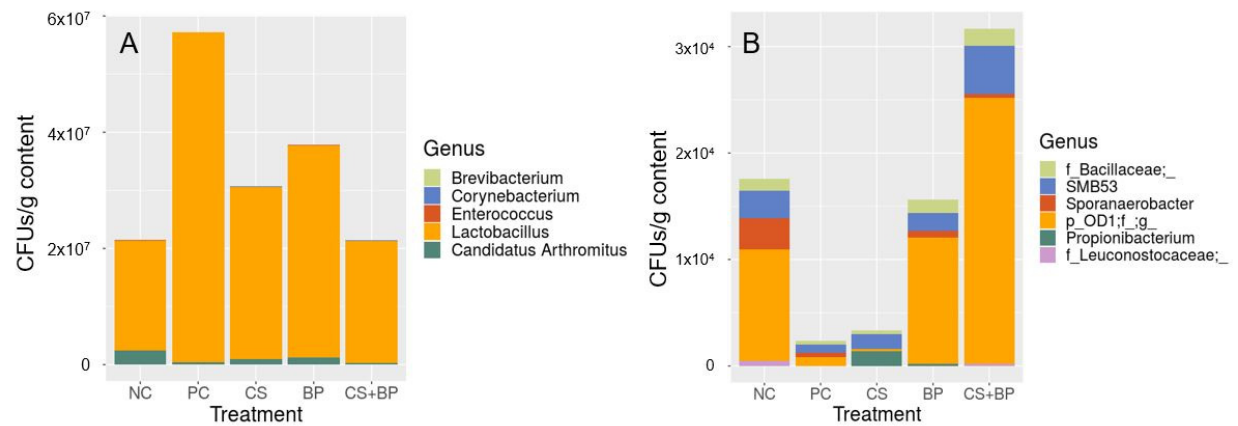
Figure 6 . Composition of the jejunal bacterial communities in five different groups of broilers at the genus level using quantitative microbiota profiling (QMP). ( A ) Genera that are ≥ 0.01% on average, and ( B ) genera that are significantly different based on either relative microbiota profiling (RMP) or quantitative microbiota profiling (QMP).